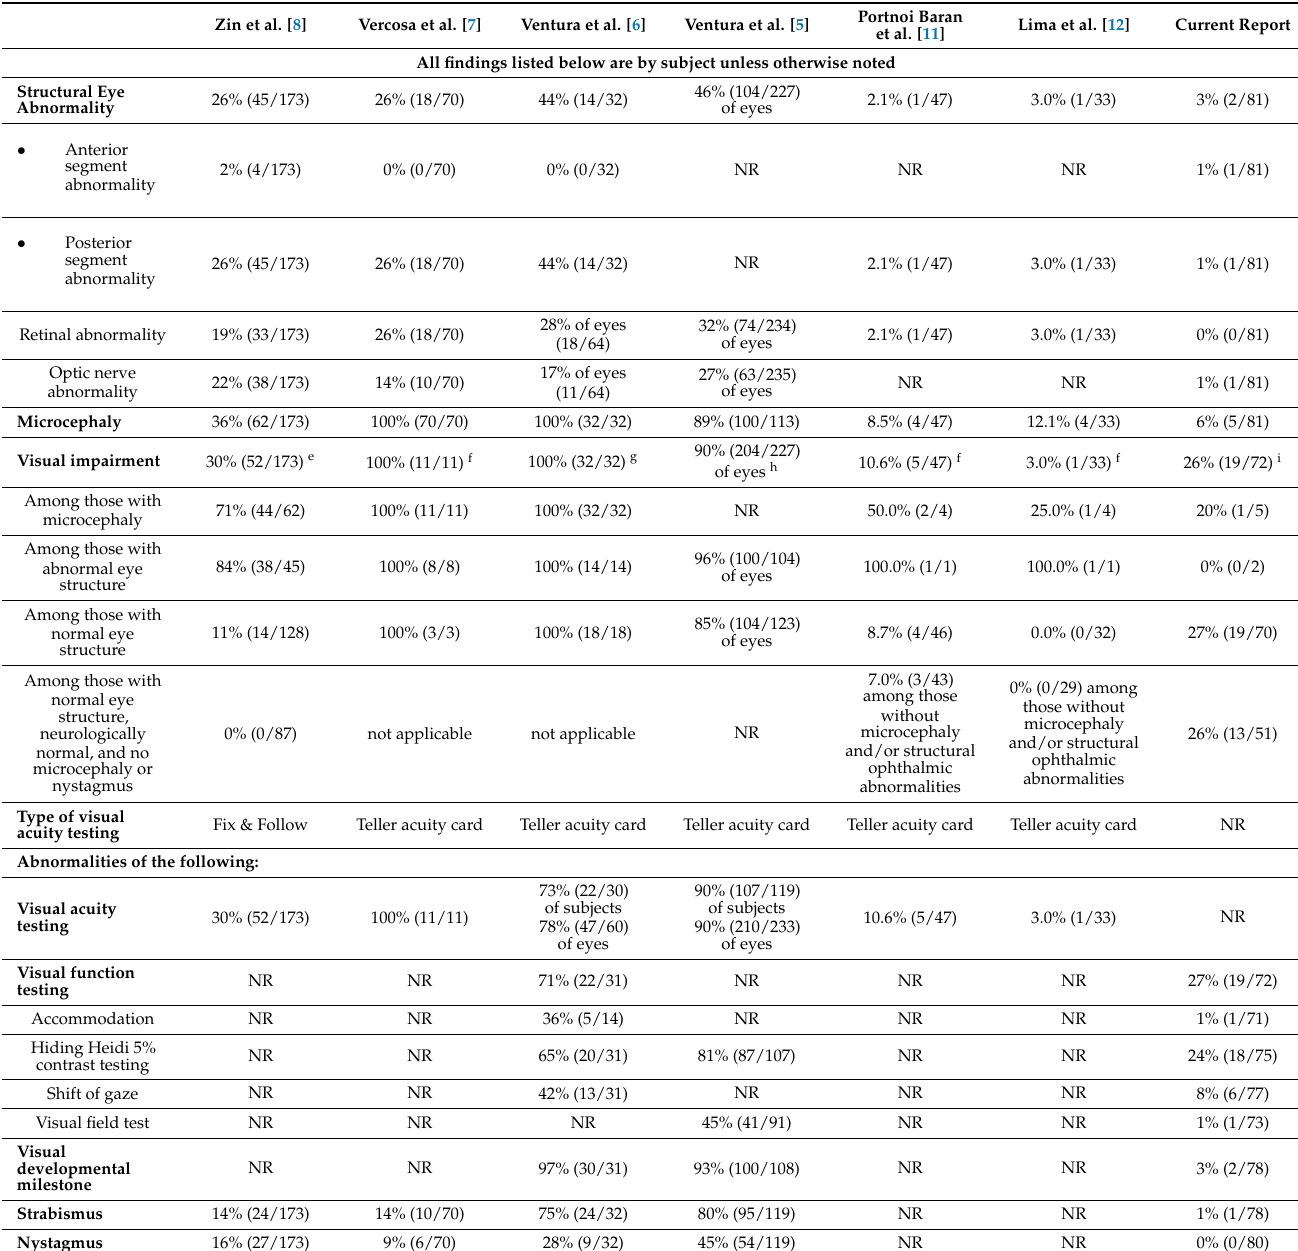
infection detected by serologic tests of maternal, fetal, or infant specimen. e For 25 children with ocular abnormalities. f Extrapolated based on abnormal visual acuity testing, the term “visual impairment” not defined in report. g Based on abnormal Teller Acuity Card vision testing and/or abnormal visual function (Hiding Heidi contrast test, shift of gaze, light perception, response to the human face) or visual developmental milestone testing. h Based on abnormal Teller Acuity Card vision testing and/or abnormal visual function (Hiding Heidi contrast test, shift of gaze, visual field test, accommodation, light perception, response to the human face) or visual developmental milestone testing. i Based on abnormal visual function (Hiding Heidi contrast test, shift of gaze, visual field test, and accommodation) or visual developmental milestone